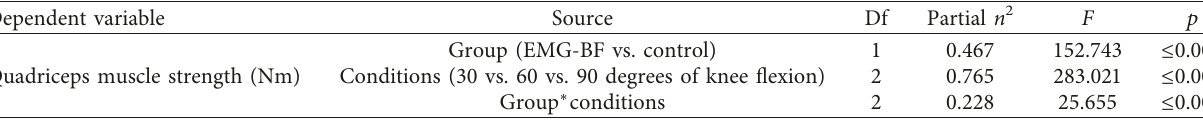
Figure 8: Comparison of quadriceps strength between training and control 3) repeated measures analyses of variance. ×